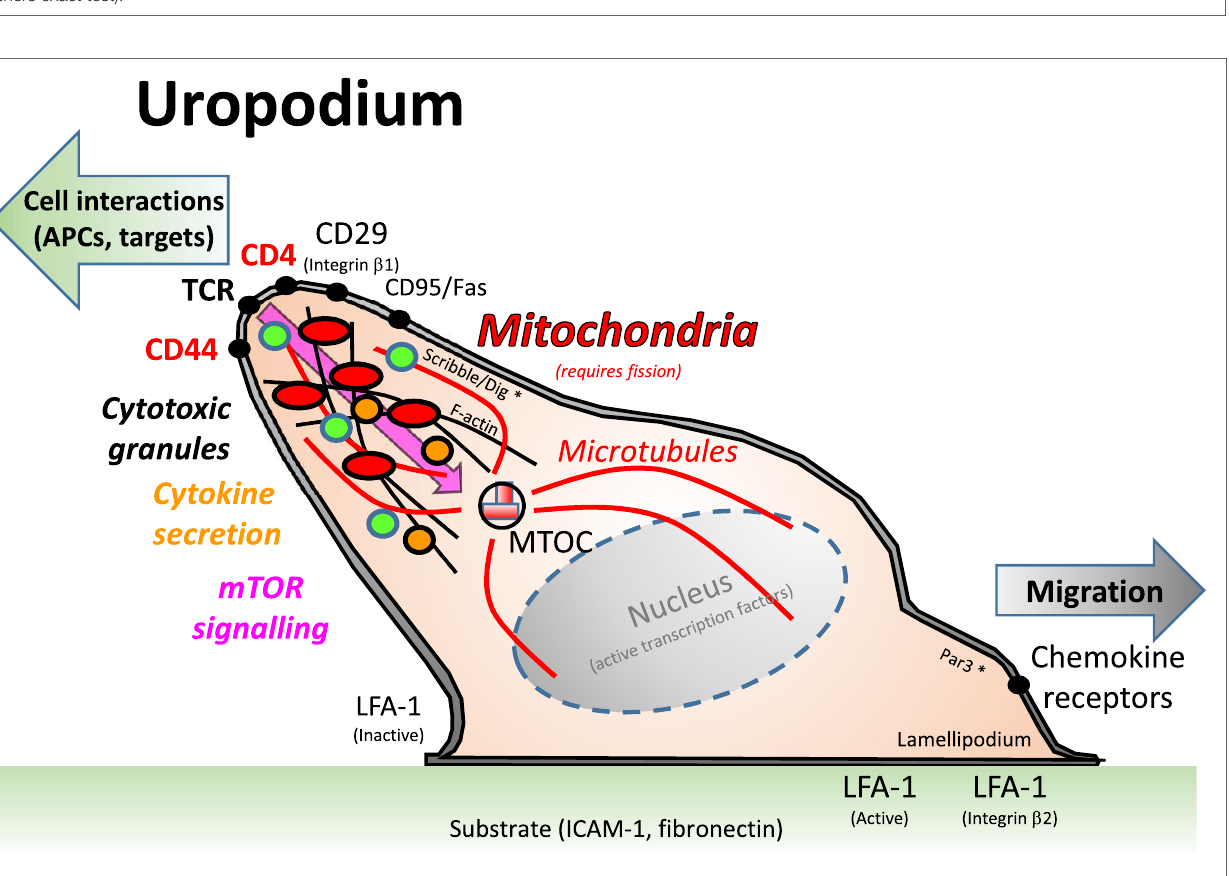
FigUre 6 | The CD4 + T cell fate choice associated with uropodium development does not depend on asymmetric cell divisions. (a) Depiction of a binary cell fate decision as a result of an asymmetric first cell division. The effector and memory cell fates result from a differential inheritance of mitochondria, CD4, and PI3k signaling between the two daughters. (b) A stochastic cell fate decision to develop uropodia during initial activation and before any cell division. The chance of any individual cell becoming either an effector cell, and developing uropodia, or a memory cell without uropodia, depends on the balance of a number of interacting signaling pathways (e.g., GITR, mTORC1, mTORC2, and NF κ B) during its initial activation. Symmetrical cell divisions can then take place regardless of the cell fate decision taken. (c–O) CTV labeled naïve CD4 + T cells from female A1RAG were stimulated with bone marrow derived dendritic cells + 100 nM Dby peptide with IL-2, TGF β , and ATRA for 48 h (when the average number of cell divisions was only 0.7). No mitotic inhibitors were used. Cultures were labeled “ in situ ” with (c,l) CD4-APC-Cy7 and CD25-BV605 or (D,M) CD44-APC-eflour780, plus live/dead aqua and Mitotracker DR (c,e,n) , and fixed at 37°C by the addition, without mixing or disturbing the cultures, of 40% formaldehyde to 10% v/v for 15 min. The medium and fixative were then carefully aspirated and fix/perm buffer added for 2 h at 37°C. Intracellular stains used were [ (c) and where indicated]: IRF4-PE, ROR γ t-PE-CF594, 7AAD or [ (D,P) and where indicated]: Sytox Green, Foxp3-PE- Cy7, NF κ B-p65-APC or [ (e) and where indicated]: Tbet-Alexa488, ROR γ t-PE-CF594, 7AAD followed by ImageStream analysis. Telophase and late anaphase cells were automatically gated and all identified cells expressing the marker of interest are included in the histograms of polarity scores (with numbers indicated). Cells in their first mitosis (i.e., undiluted CTV) are indicated in yellow, while cells from all subsequent divisions are in blue. Data shown are from ~850,000 images obtained by pooling four independent experiments (two under standard, one each under Th1 or Th2 cytokine conditions). A polarity score of 0 represents complete symmetry, while 100% represents full asymmetry. A polarity score threshold of 40% was set (representing a 2.4-fold difference in intensity between daughters). This threshold indicated apparent asymmetry for DNA staining in 10% of the telophase cells (consistent with the error in DNA intensity measurement: robust CV of G 0 /G 1 peak = 30%). P values indicate the probability that the cells analyzed were sampled from a population, where 50% or more of the cells were asymmetric (Fishers exact